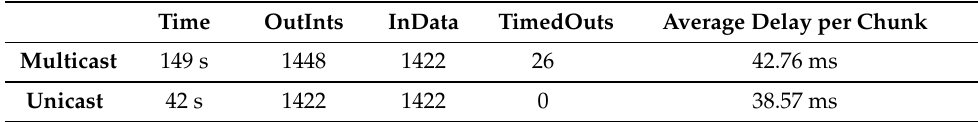
Table 4. Total download time using multi-technology and non-pipelined application. Time OutInts InData